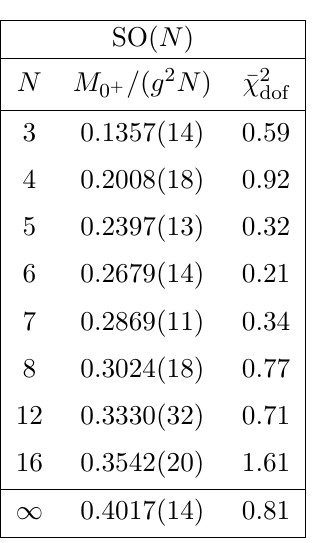
Table 29 . Continuum glueball masses in string tension units, M G = SO(16), with the (cid:31) 2 per degree of freedom of the linear extrapolation. Reliability as graded in tables 24{27.